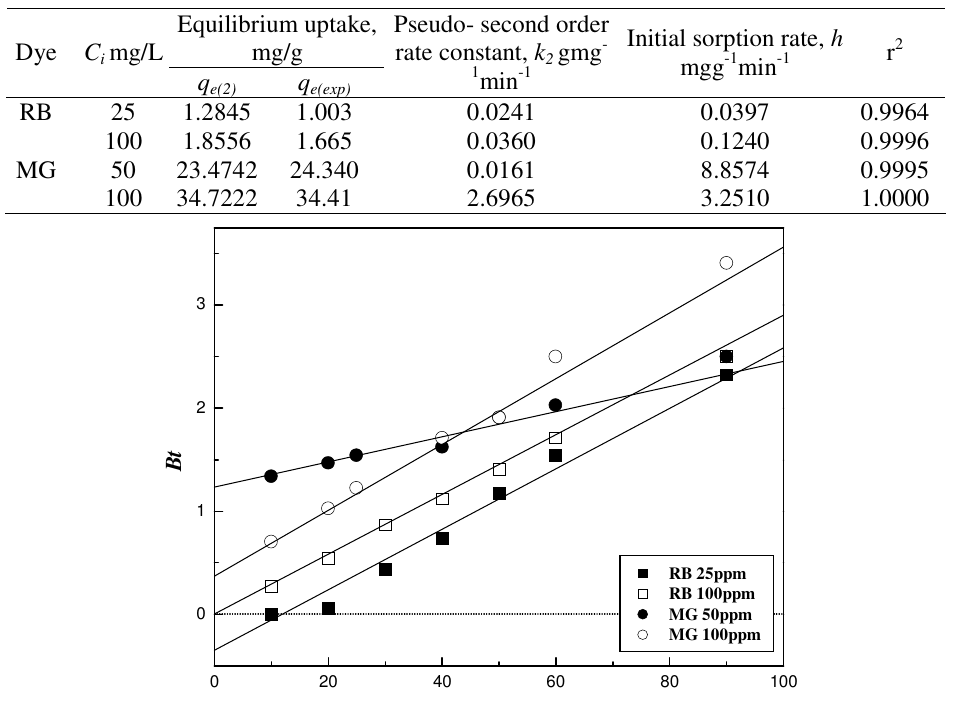
Table 4. Pseudo-second order parameters for adsorption of dyes at 30 ° C